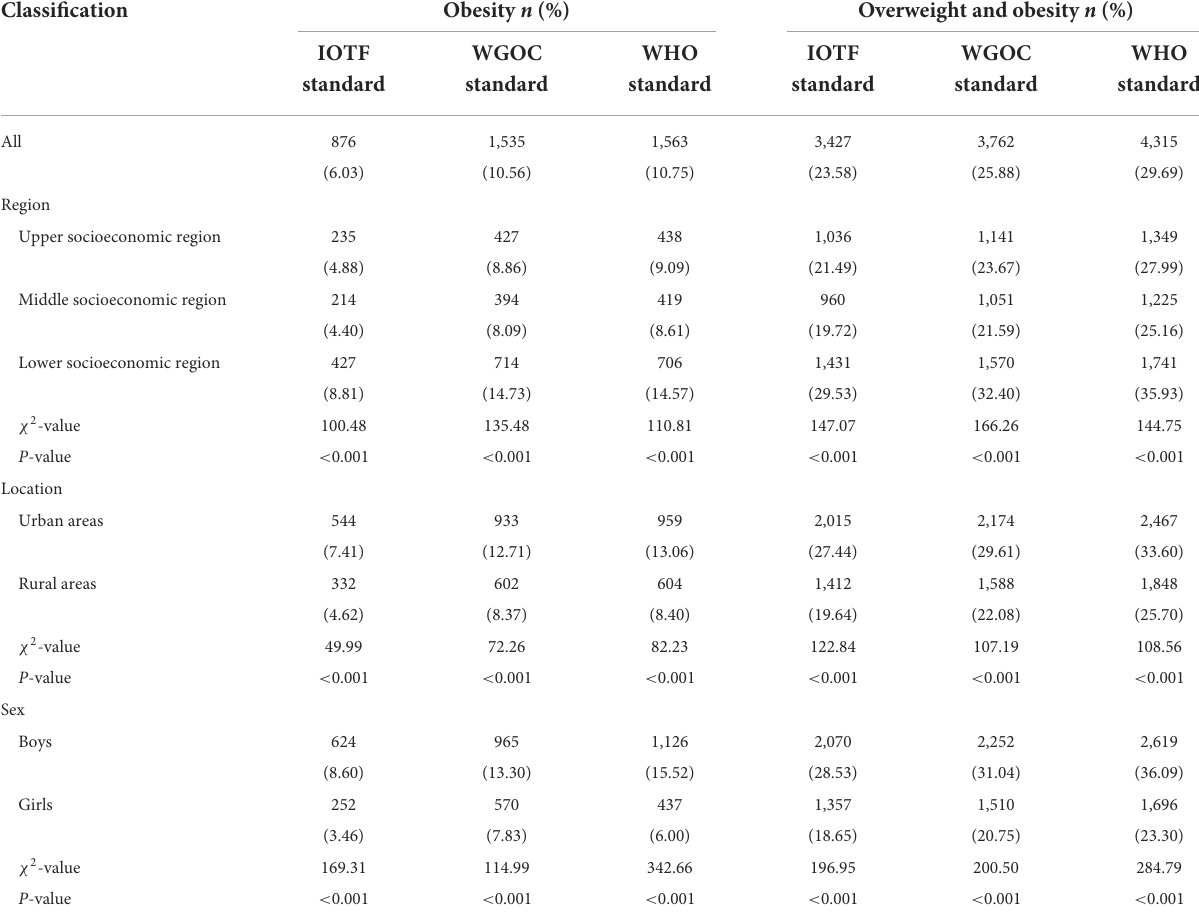
TABLE 2 The prevalence of overweight and obesity determined by three standards in Henan Province, China in 2019.